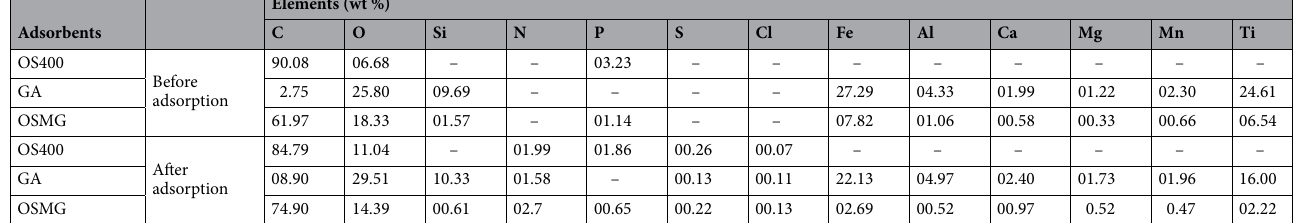
Table 1. Chemical microanalysis of OS400, GA and OSMG before and after adsorption process.